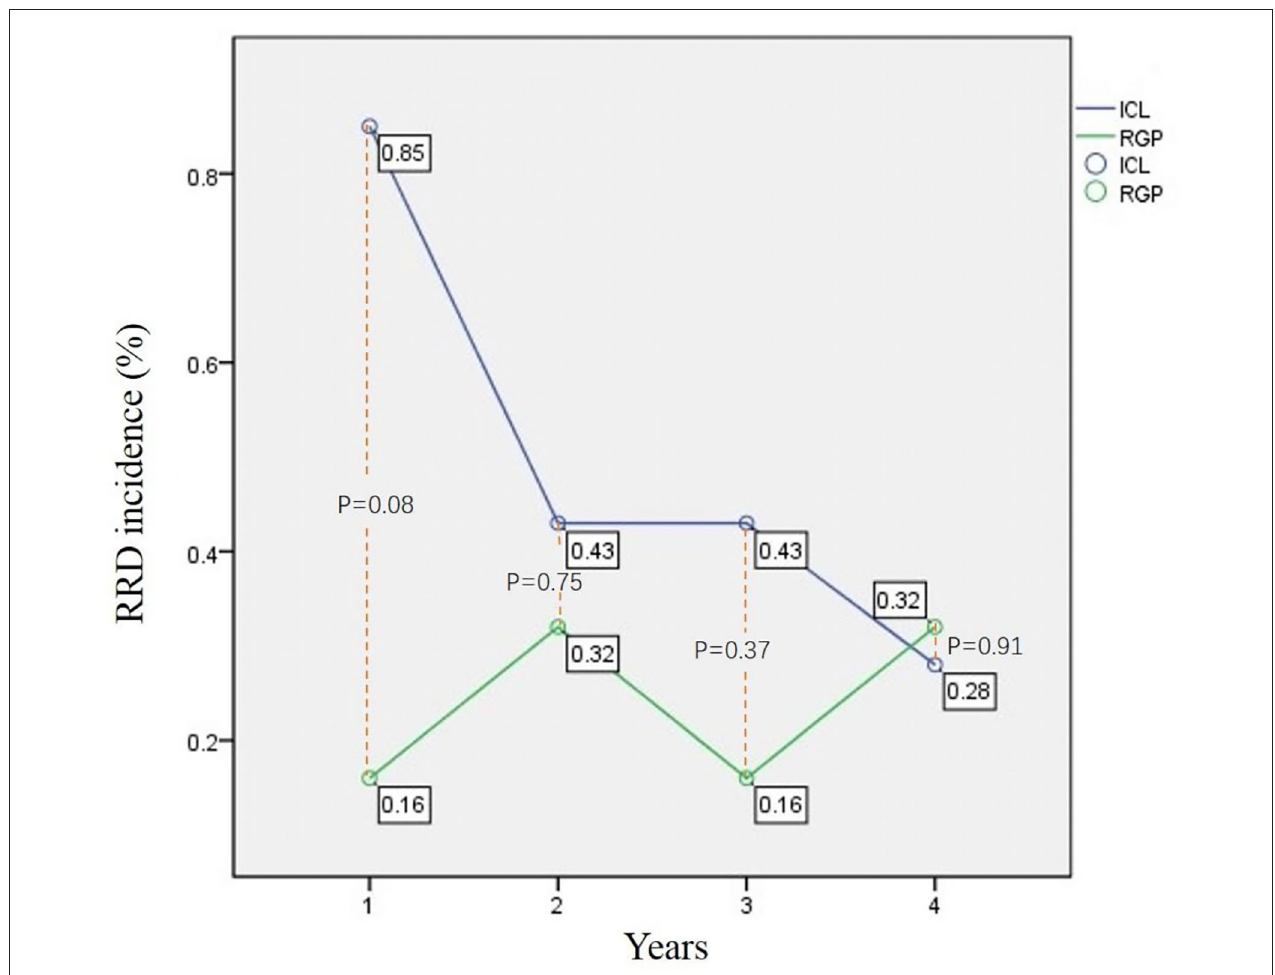
FIGURE 1 | RRD incidence trend of ICL group and RGP group. X-axis is time axis. 1, the first year after refractive procedure; 2,the second year after refractive procedure; 3, the third year after refractive procedure; 4, from the beginning of the fourth year after refractive procedure to the end of follow up. This figure shows the RRD incidence trend of ICL group and RGP group in different time after the refractive procedure. The blue line is ICL group and the green line is RGP group. The ICL line is above the RGP line. However, the difference was not statistically